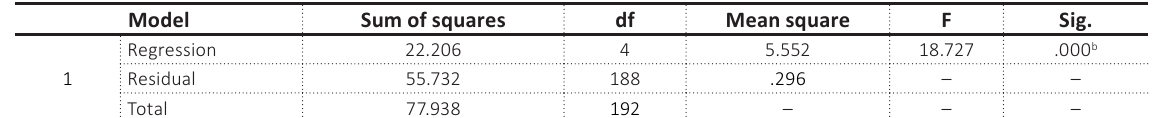
Table 8. ANOVA a